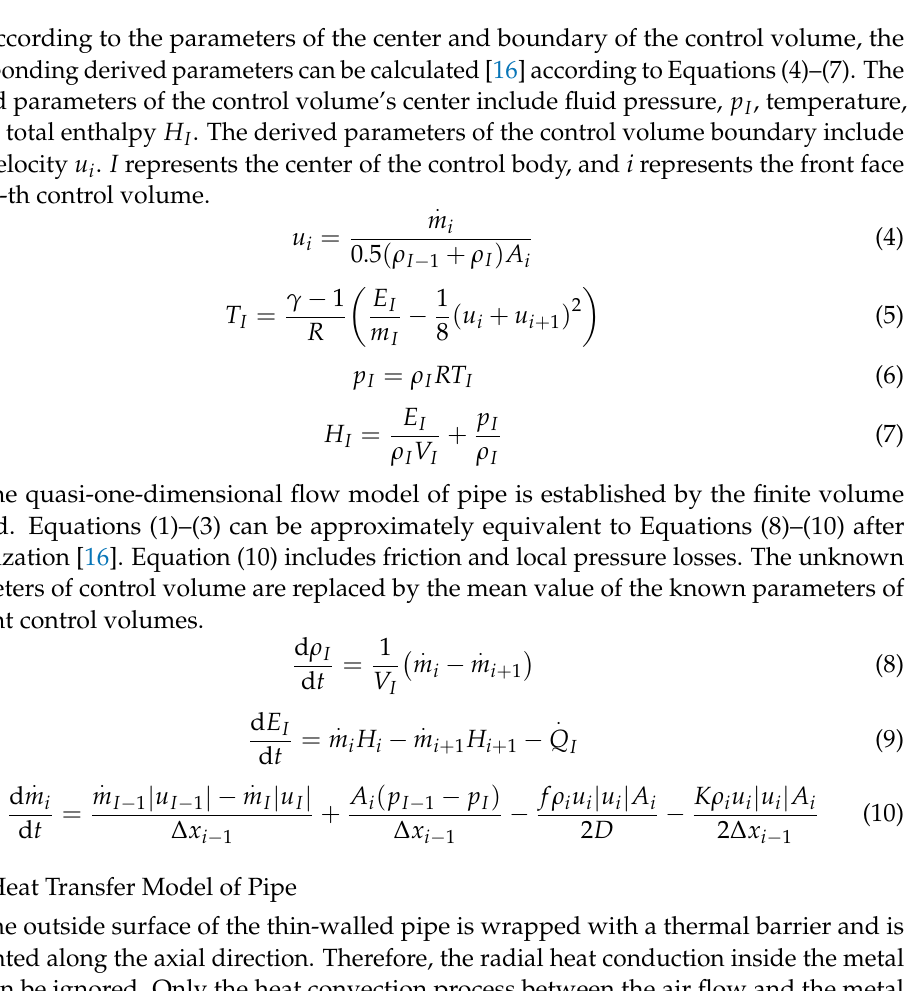
Figure 1. Schematic diagram of axial grid division of